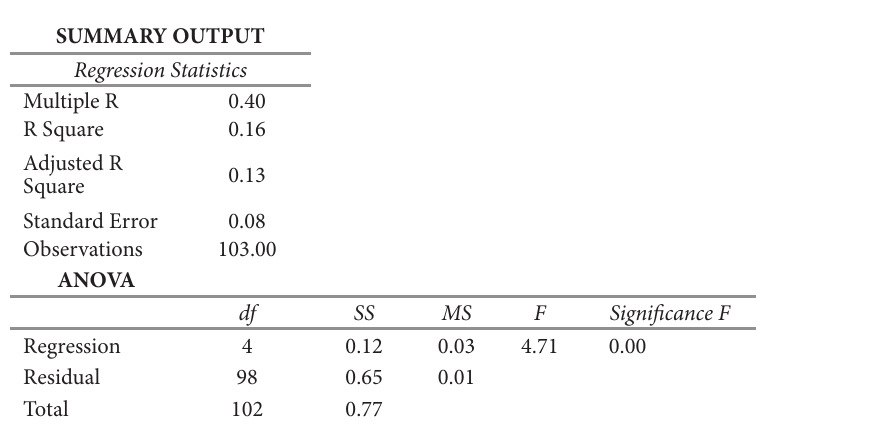
Table 7. Regression results for the arbitrary pricing